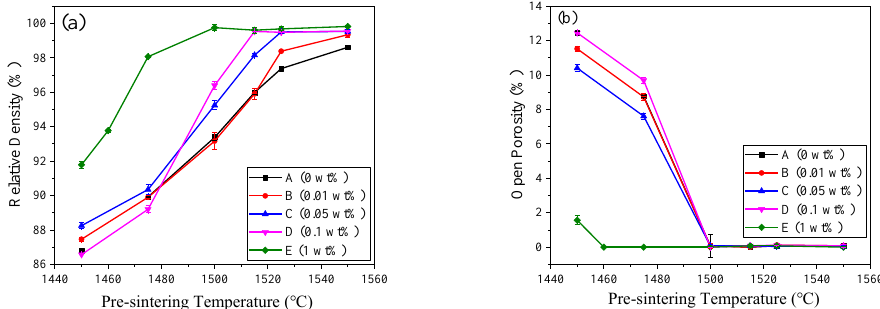
Figure 1. Densification process of samples A to E pre-sintered in the range of 1450–1550 °C: ( a ) relative density with respect to the pre-sintering temperature; ( b ) open porosity versus the pre-sintering temperature.